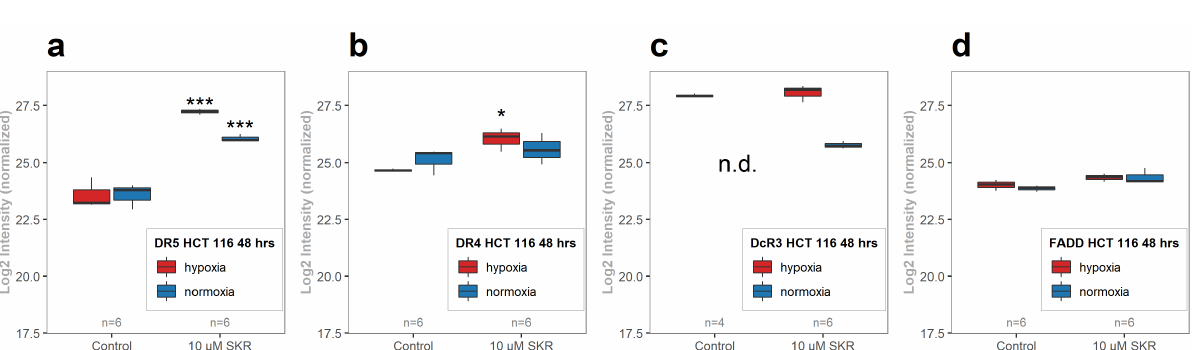
Figure 5. SKR after 48 h treatment of HCT 116 cells increases the expression of DR5 on protein level. Normalized log2 intensity of Death receptor 5 (DR5) protein ( a ), DR4 ( b ), DcR3 ( c ) and FAS-associated death domain protein (FADD) ( d ) evaluated by MS. The boxplots represent at least three independent experiments. DcR3 was not detected in normoxic control. The number of samples (n) is noted in plots. The experimental groups were compared with the matching control group (* p < 0.05, *** p < 0.001). n.d.— not